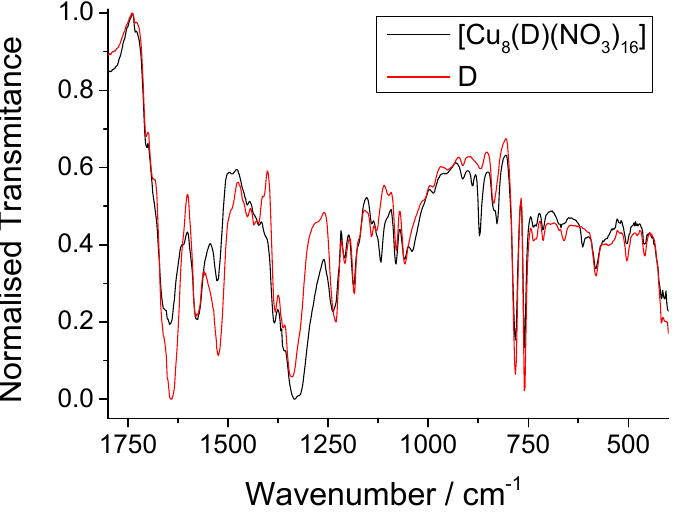
Figure 1. FTIR spectra of dendrimer D and its Cu(II) complex [Cu 8 (D)(NO 3 ) 16 ].